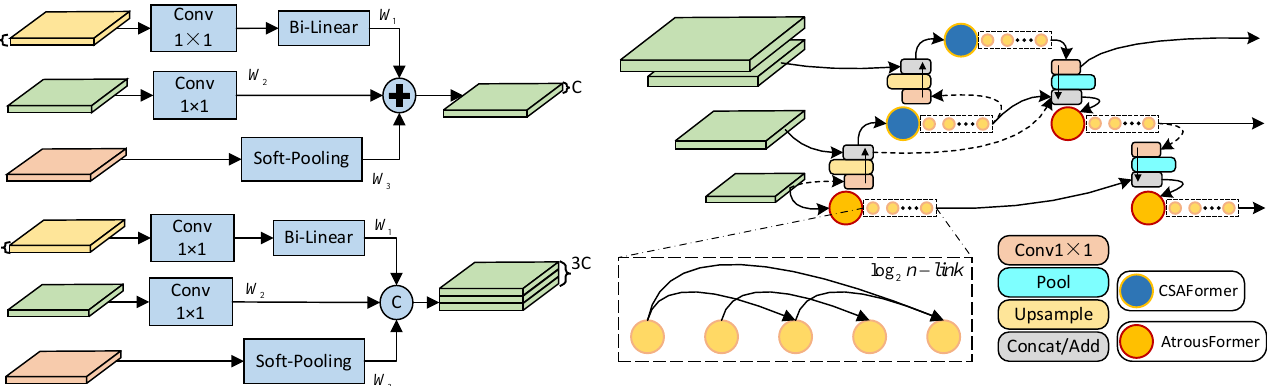
Figure 5. Adaptive weight fusion module and multi-scale fusion Neck structure.